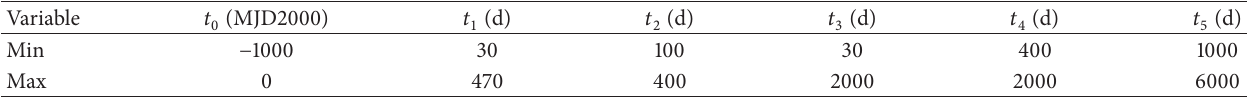
Table 1: Value range of each variable in Cassini.